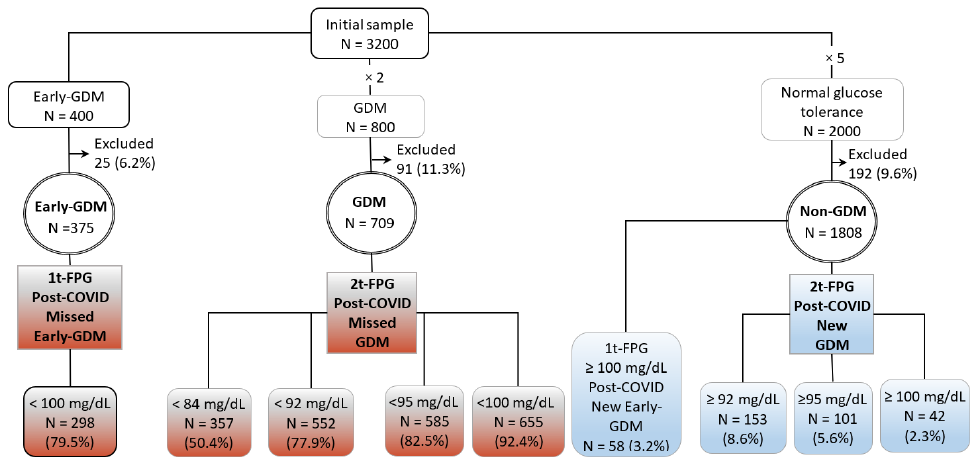
Figure 1. The initial and final samples included in this study. Pregnant women with gestational diabetes mellitus (GDM group), with GDM diagnosed in the first trimester, (Early-GDM group) and women with normal glucose tolerance in pregnancy (Non-GDM group), according the two-step diagnosis criteria (18), are indicated. The Post-COVID-19 Missed- and New-Early-GDM groups were identified according to the recommendations of Spain (4) for the Early-GDM diagnosis during pandemic, first trimester fasting plasma glucose (1t- FPG) < or ≥100 mg /dL, respectively. The post-COVID-Missed-GDM and post-COVID-New-GDM groups were identified according to the recommendations of Australia (1), Italy (2), Spain (3), and UK (5), FPG at 24 – 28 weeks of pregnancy (2t-FPG) <84, <92, <95 and <100 mg/dL, respectively or ≥92, ≥95 and ≥100 mg /dL, respectively. GDM, gestational diabetic mellitus; NDDG, National Diabetes Data Group; post-COVID, post-coronavirus disease.